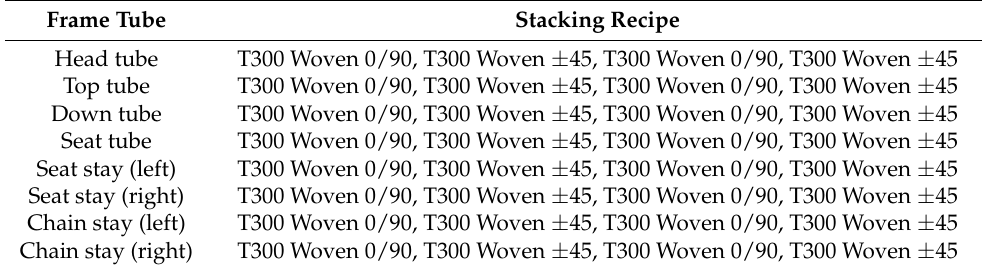
Table 3. Quasi-isotropic layup using T300 Woven